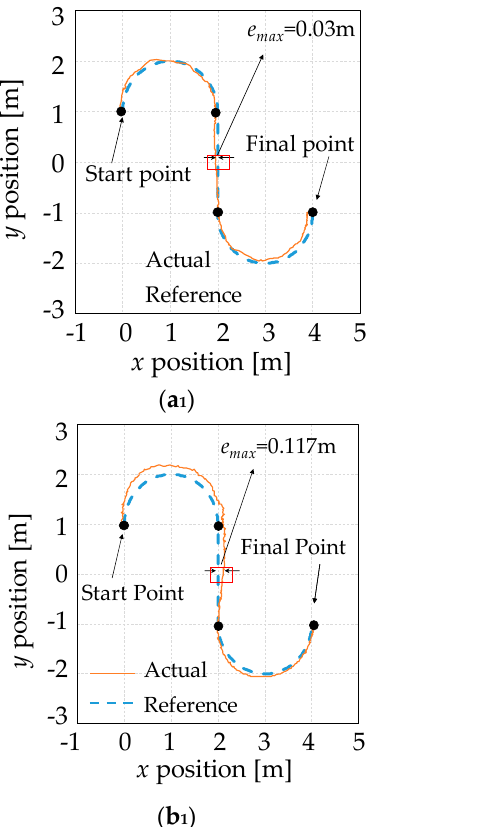
Figure 16. Path tracking results (with robust compensation: ( a 1 ) no goods; and ( a 2 ) 10 kg goods on an off ‐ center position) (non ‐ robust compensation: ( b 1 ) no goods; and ( b 2 ) 15 kg goods on same position with ( b 1 ).